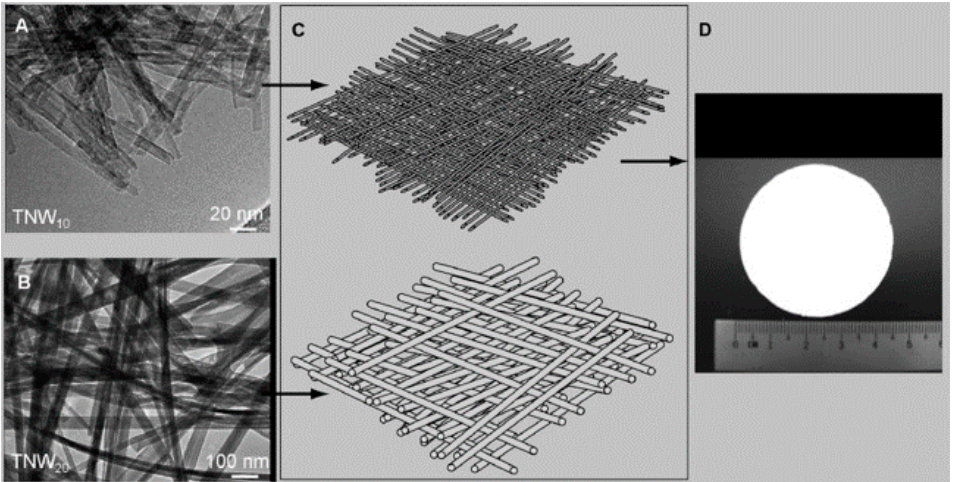
Figure 9. Components of the hierarchical layer of the TiO 2 nanowire ultra-filtration (UF) membrane. ( a ) Transmission electron microscopy (TEM) image of TiO 2 nanowires with diameter of 10 nm (TNW 10 ); ( b ) TEM image of TNW 10 ; ( c ) schematic profiles of the TiO 2 nanowire UF membrane; ( d ) digital photo of the TiO 2 nanowire UF membrane. Figures are reprinted with permission from Ref. [102]. Copyright Wiley-VCH, 2009.